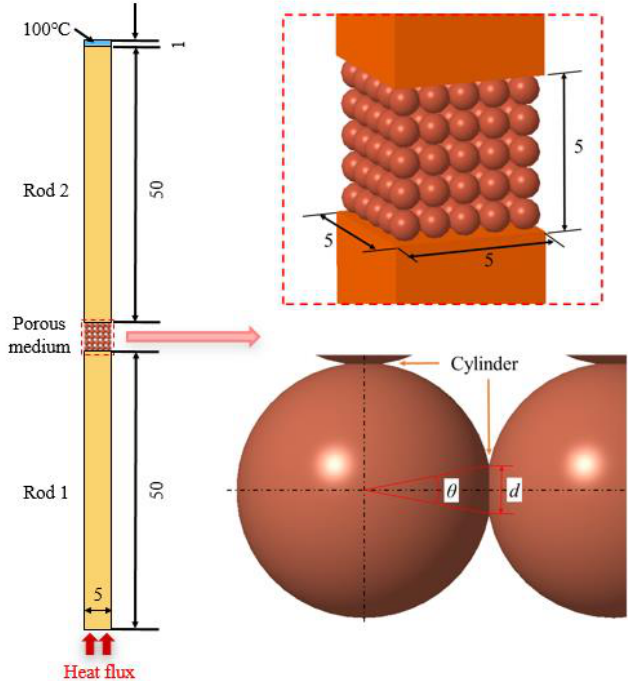
Figure 1. Simulation model for evaluating effective thermal conductivity.